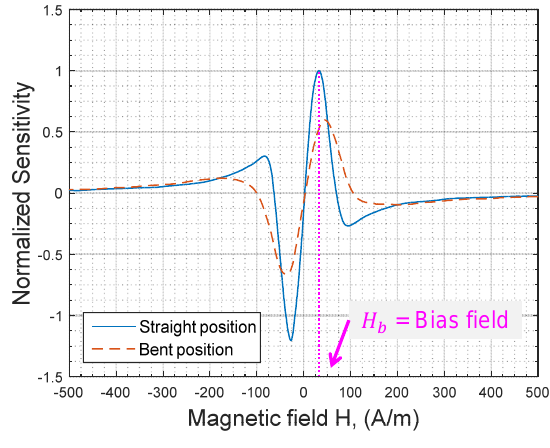
∂ | Z ( H ) | , under bending stress. The sensitivity was 214 )(cid:16)|(cid:17)((cid:11))| , under bending stress. The sensitivity was 4((cid:11) (cid:13) (cid:16)(cid:11) ∂ H S ( H b ) , obtained in a straight position of the 215 (cid:7) )